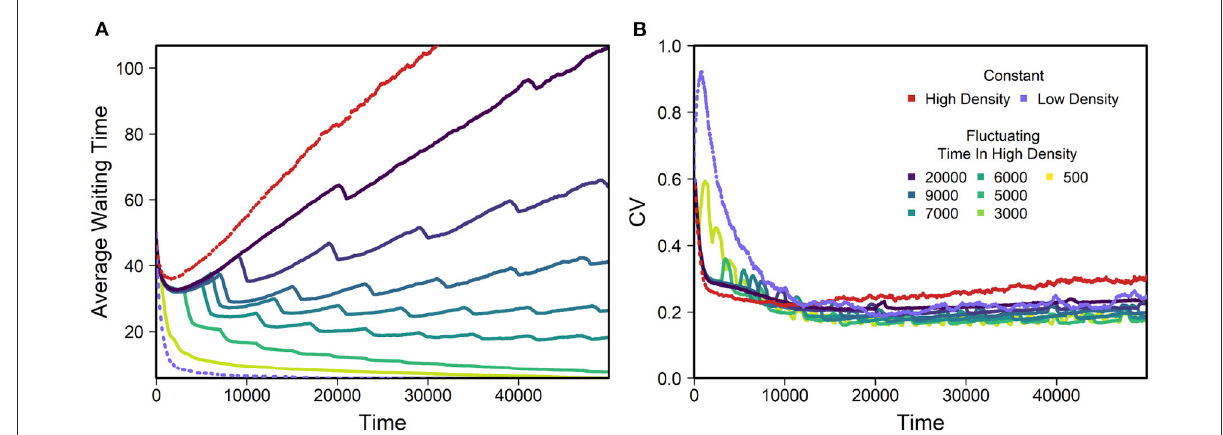
FIGURE7 Example of average WT (A) and coefficient of variation (CV, B ) for different patterns of density fluctuations. Average within replicate CV calculated over all replicates. The color-scaled lines show evolution for density fluctuations, while the light purple and red line show data for constant densities of g = 70 and g = 300, which were used as high and low densities. Fluctuations were assembled in a way that populations were exposed to high or low densities for a certain time, before switching to the other situation (example Supplementary Figure 1). All replicates spent 1,000 days in low density and the time in high density was as stated in the legend. All replicates began at high density. Default values as in Table 1 were used and different regimes of density fluctuations applied. We used 630 replicates per